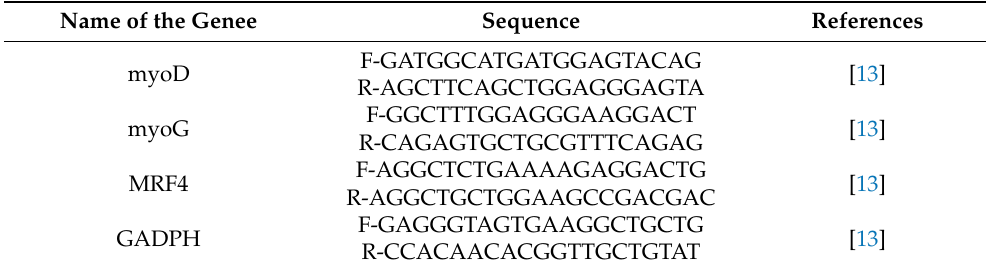
Table 1. Sequences of the rtPCR primers of the target genes MyoD, myogenin, and MRF4, and